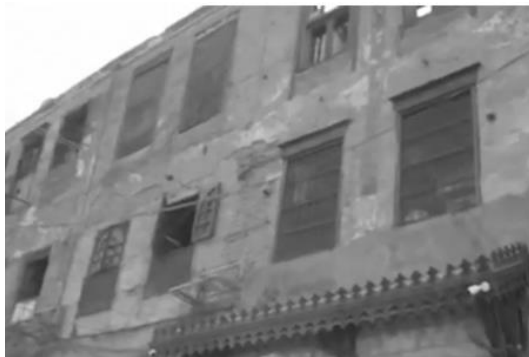
Figure 4. Deterioration of Wikāliẗ ạl-’Anbariyin's interior. (Source: Dardasha Tareq, 2019. https://www.youtube.com/watch?v=-ZtLLsrwJU8) 2015